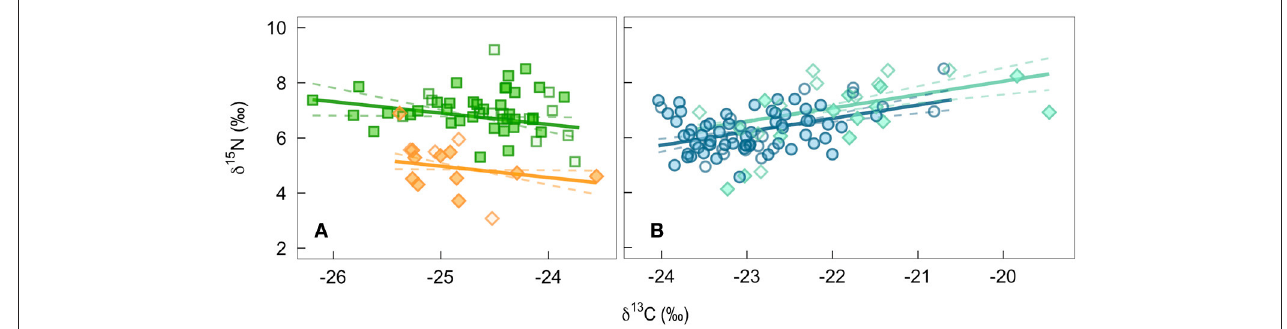
FIGURE 2 | The population level predicted effect on δ 15 N of a change in δ 13 C of bird tissues from a mixed-effect model controling for breeding site: (A) feathers grown by adults on the breeding grounds (green squares) or by nestlings being fed by parents (orange diamonds), and (B) winter-grown claw from birds during their first year of life (turquiose diamonds) and older adults (blue circles). Filled symbols are males, open are